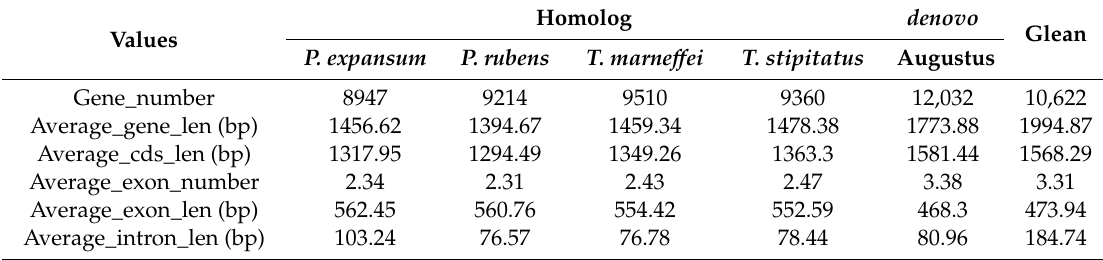
Table 2. Gene prediction results using homologous and de